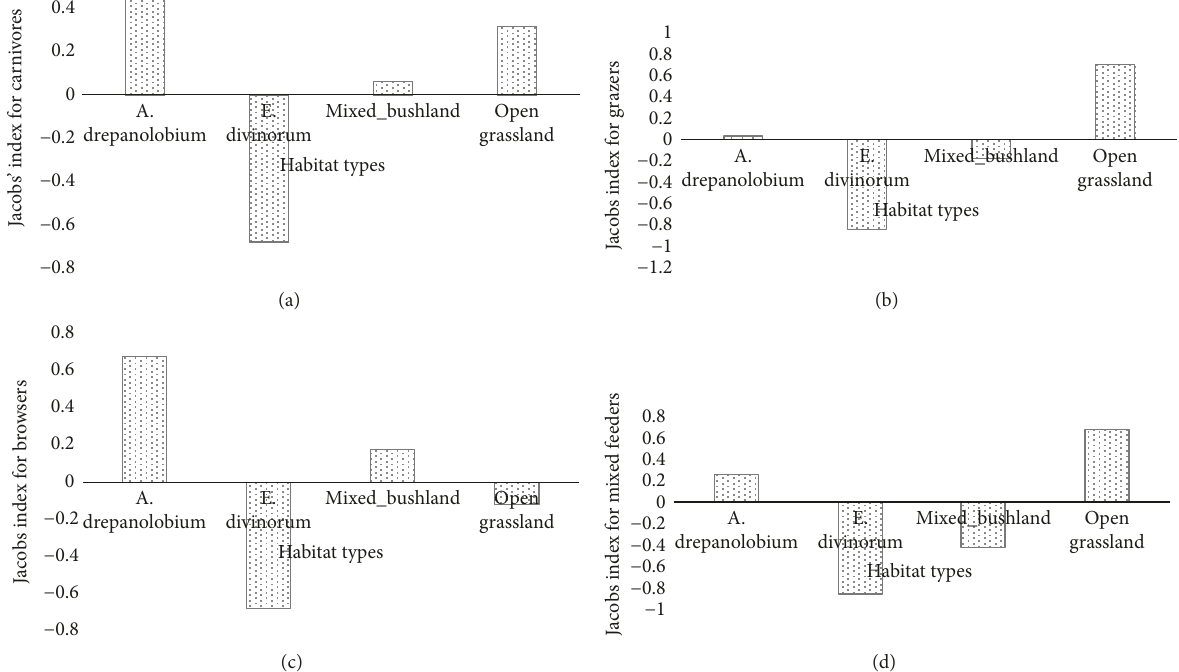
Browsers showed preference for A. drepanolobium (𝐷 = 0.674) and mixed bushland habitat (𝐷 = 0.175) but avoided both E. divinorum (𝐷 = −0.673) and open grasslands (𝐷 = −0.116) dominated habitats (Figure 4(c)). However, mixed feeders preferred habitats dominated by open grassland (𝐷 = 0.688) and A. drepanolobium (𝐷 = 0.523) but avoided E . divinorum (𝐷 = −0.858) and mixed bushland (𝐷 =